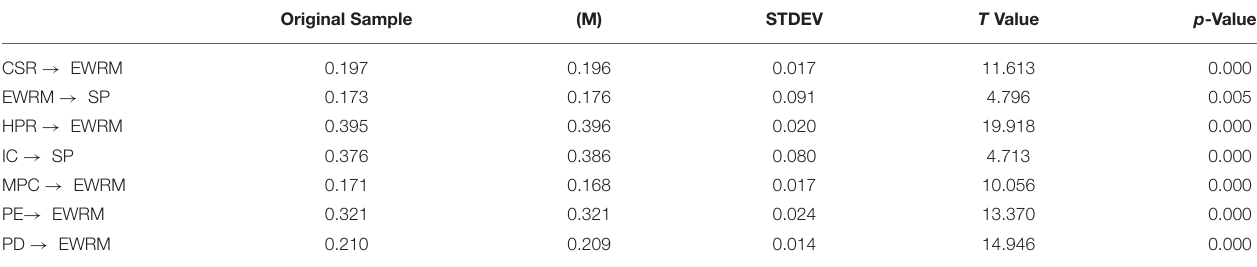
TABLE 4 | Direct hypothesis testing.